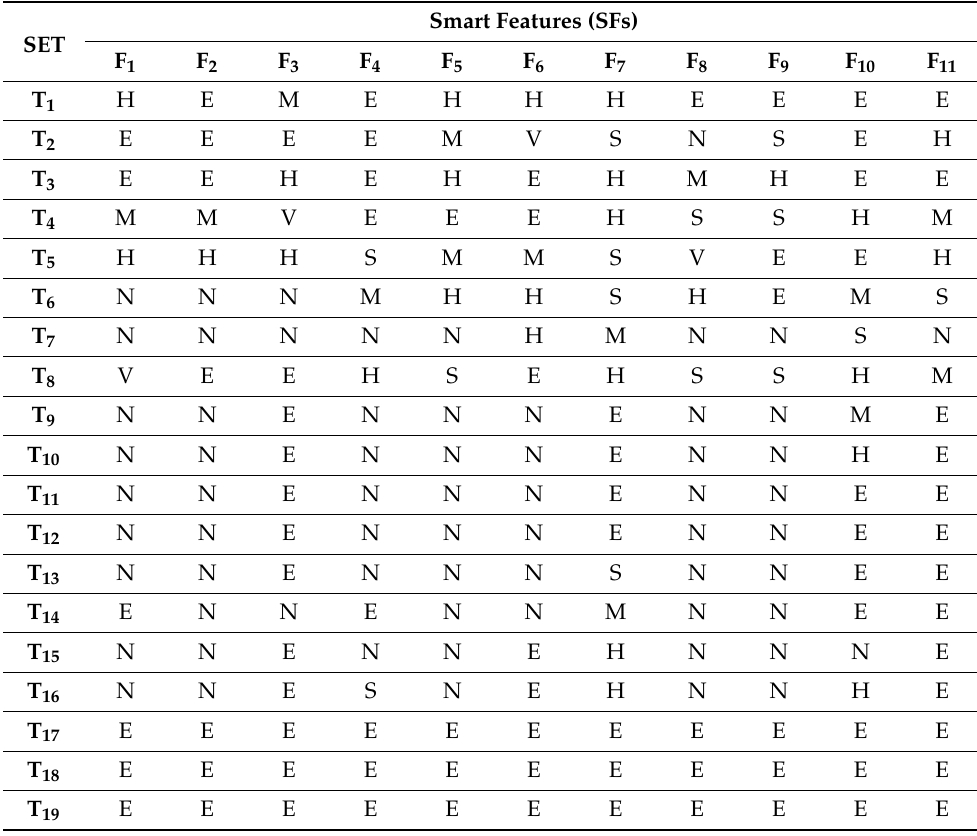
Table 3. Fuzzy relation matrix—SETs to SF “Positive impact” relations